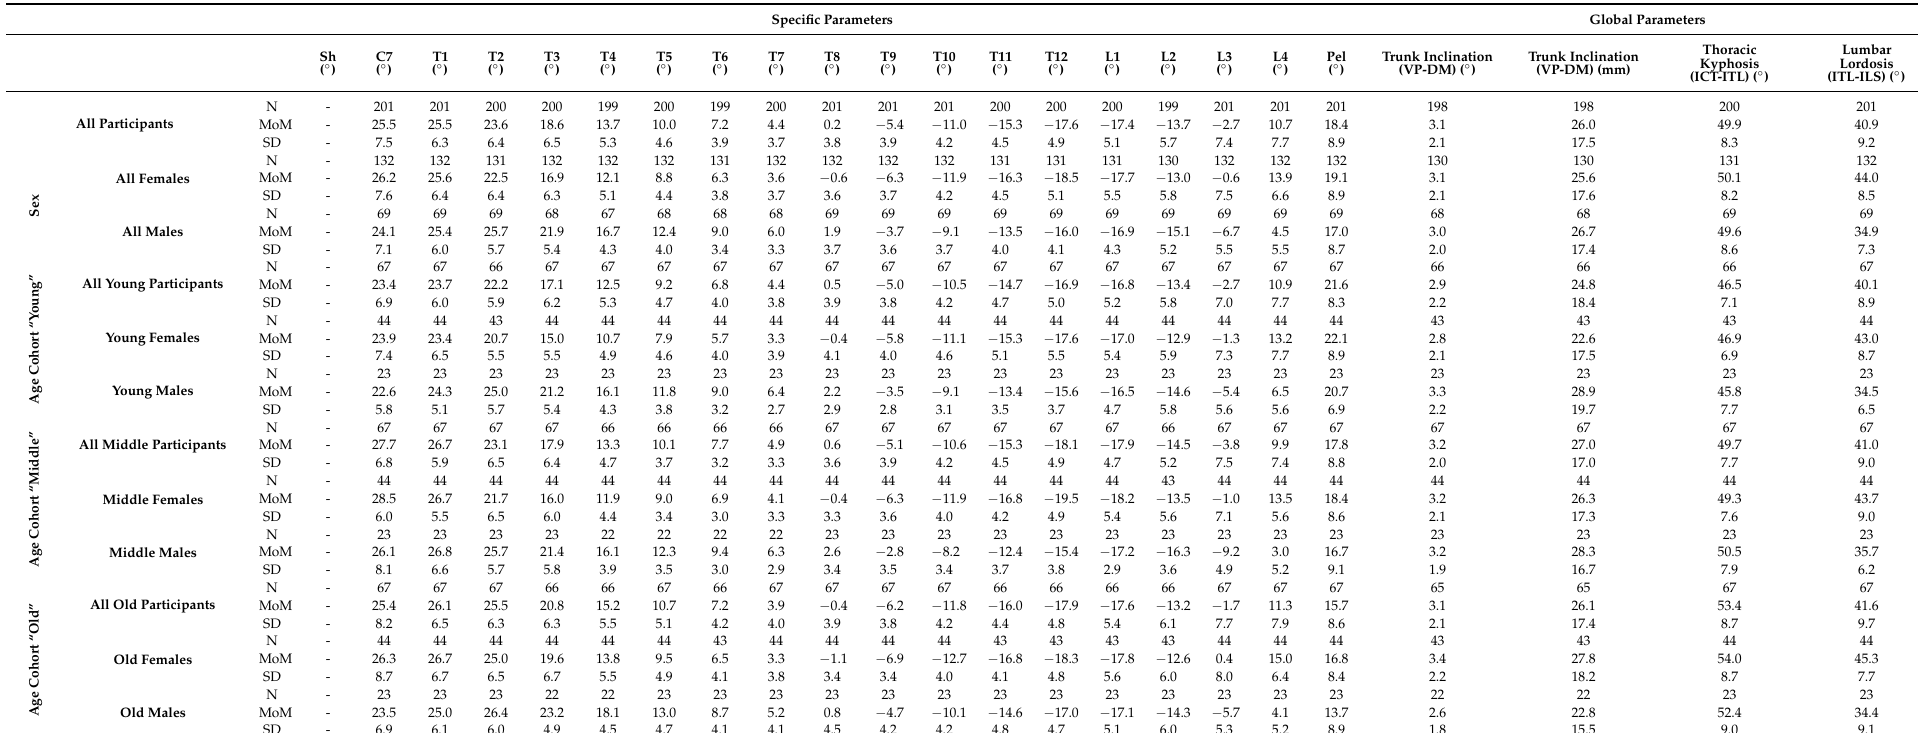
Table 4. Results of the descriptive statistical analyses (MoM ± SD) of the spinal parameters in the sagittal